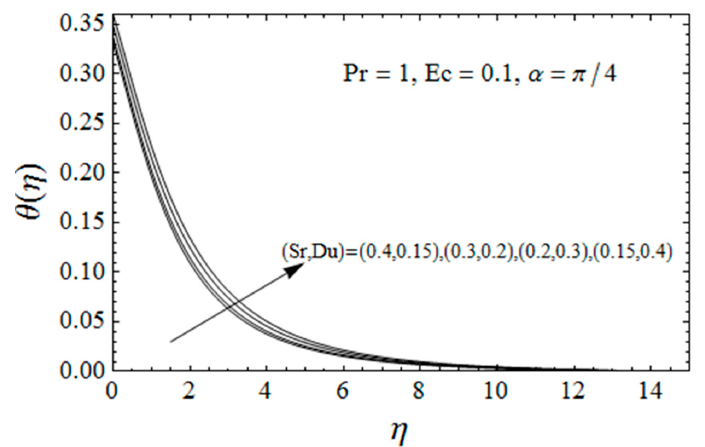
Figure 6. 𝜃(𝜂) for different 𝑆𝑟 and 𝐷𝑢. Figure 6. θ ( η ) for di ff erent Sr and Du .